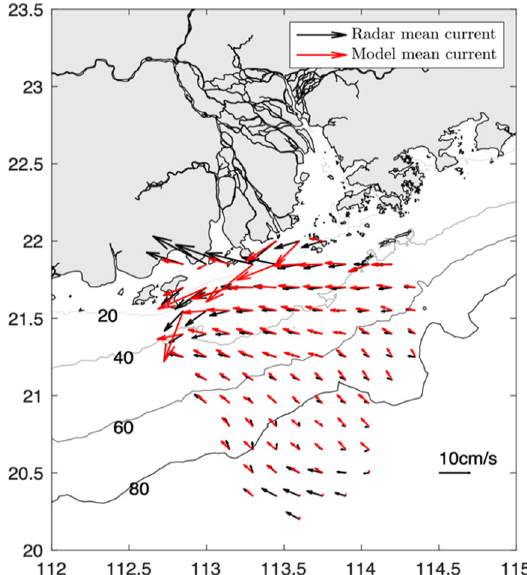
Figure 6. Comparisons of monthly averaged velocities (cm/s, vector) from radar measurements and model.